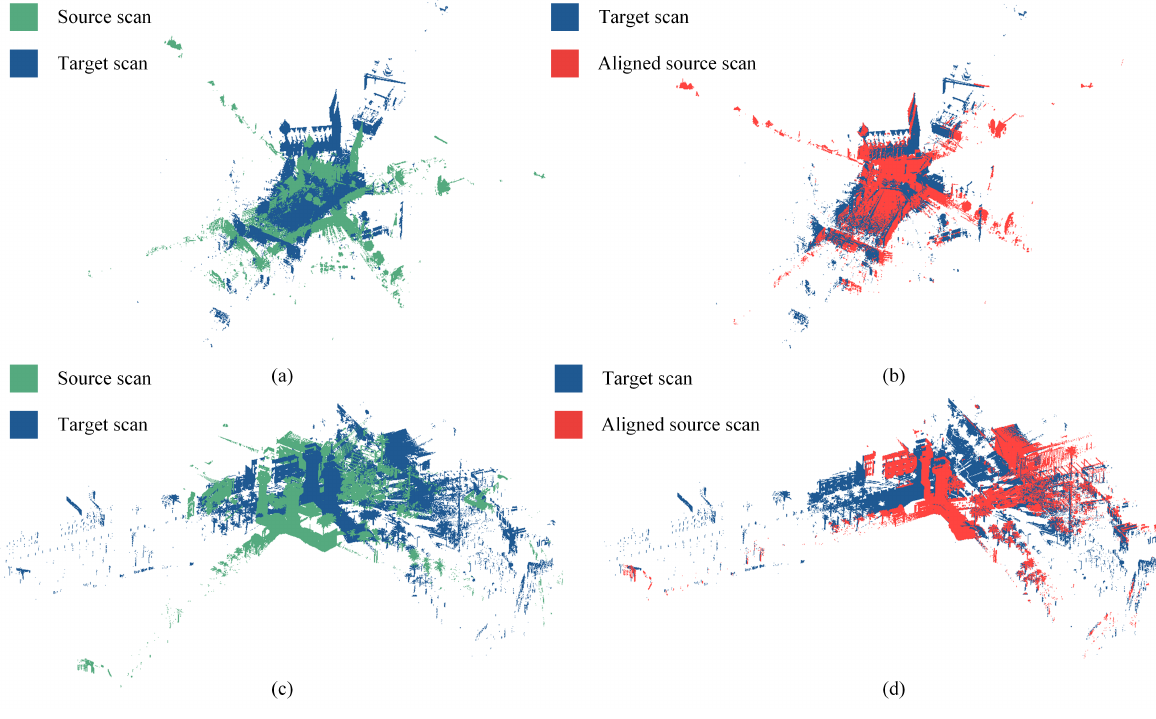
Figure 4. Coarse registration results. (a) and (b) are the source and target point clouds before registration. (b) and (d) are the coarse registration